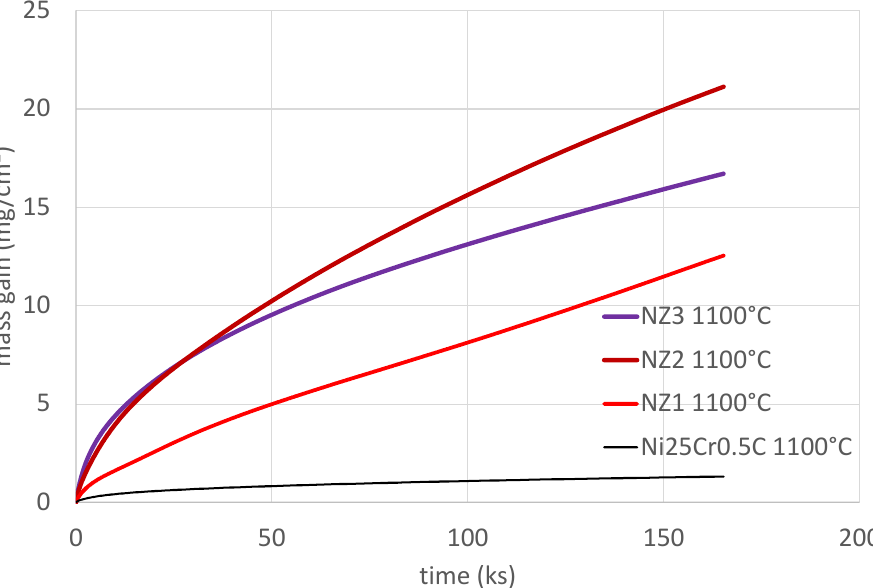
Figure 3. Mass gain recorded during the isothermal oxidation of the three Zr–containing alloys in comparison with the reference ternary alloy; “NZ1”, “NZ2”, and “NZ3” are the Ni–25Cr–0.25C–1.9Zr,